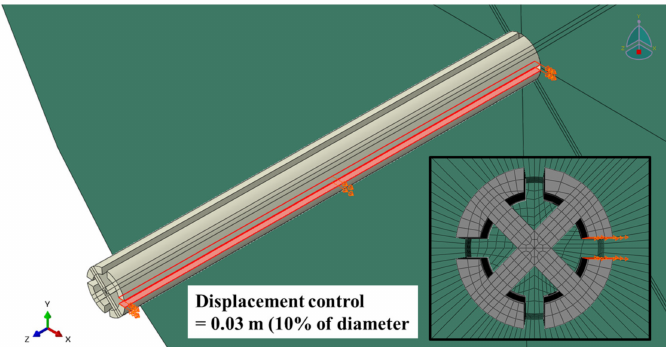
Figure 17. Tension simulation of the smart